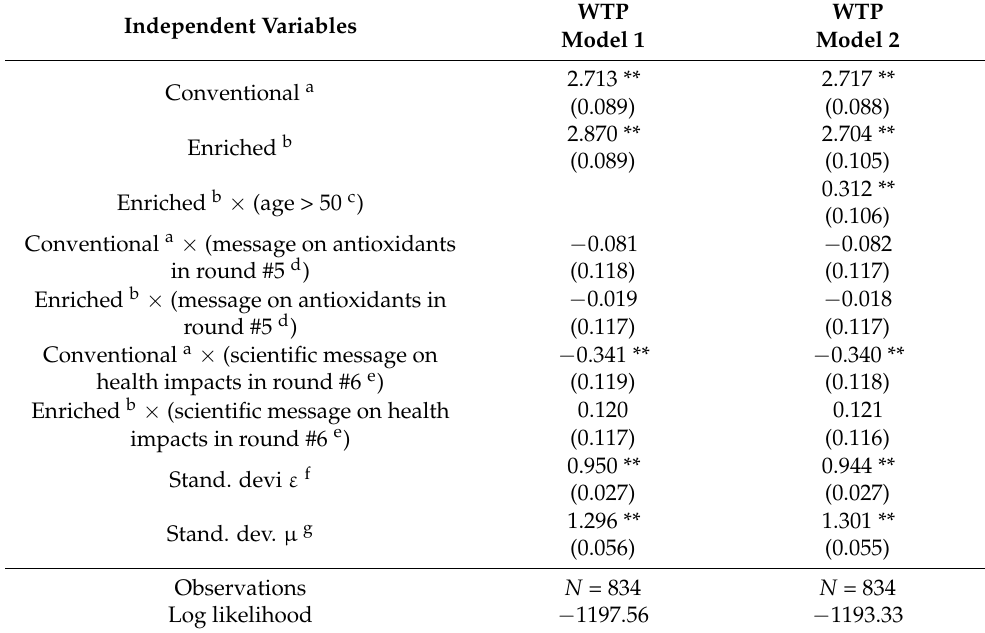
Table 3. Estimations of the pooled WTP for one packet of ham, either conventional or enriched with antioxidants, with a Tobit random effects estimator (rounds R = {4,5,6}). Independent Variables